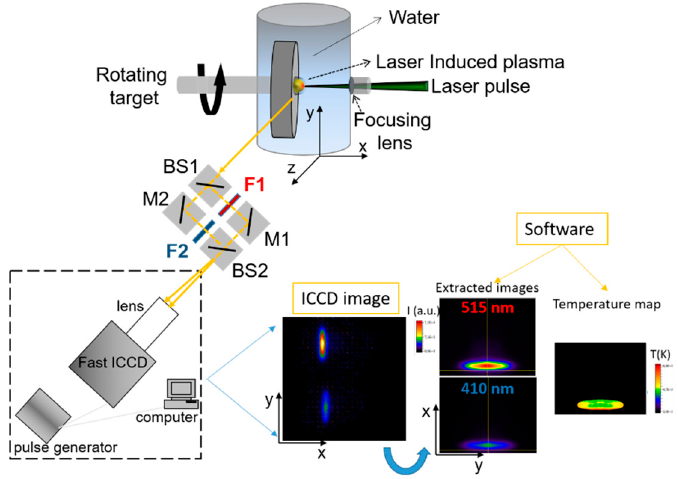
Figure 4. Experimental set-up for spectrally resolved imaging technique for the simultaneous acquisition of two plasma images at different wavelengths (515 and 410 nm).